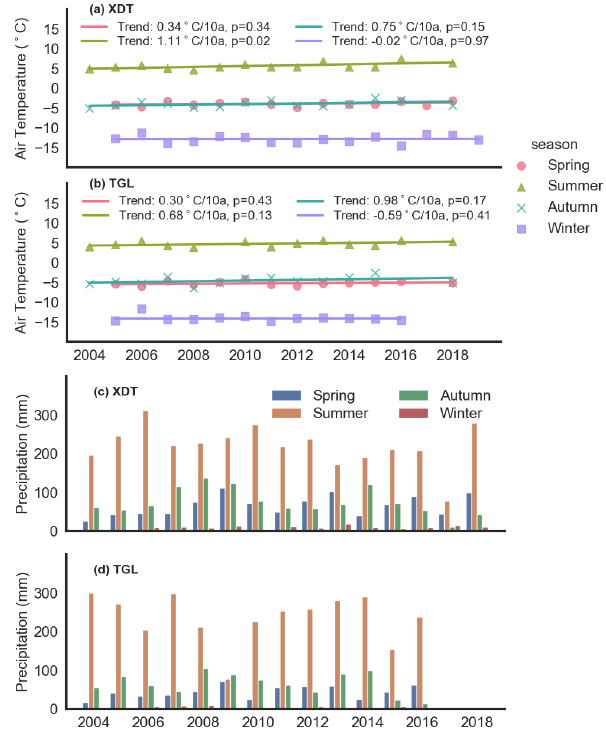
Figure 6. Seasonal mean series and changes in temperature and precipitation at XDT and TGL from 2004 to 2018.